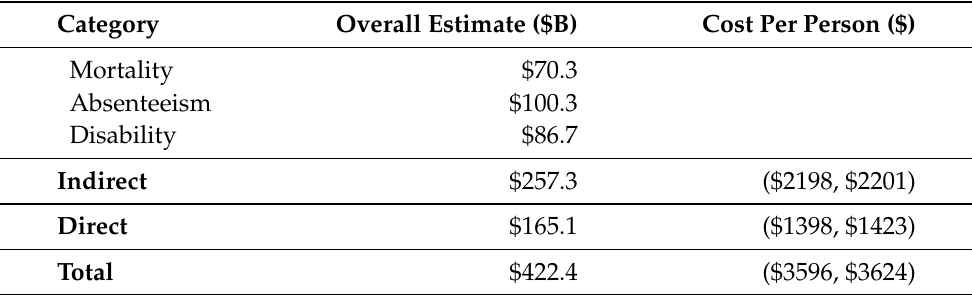
Table 4. Summary of the cost estimates by category, computed for 2018. Overall estimates in billions of dollars by category are listed in the second column. The third column shows the 95% prediction interval for the cost per person in